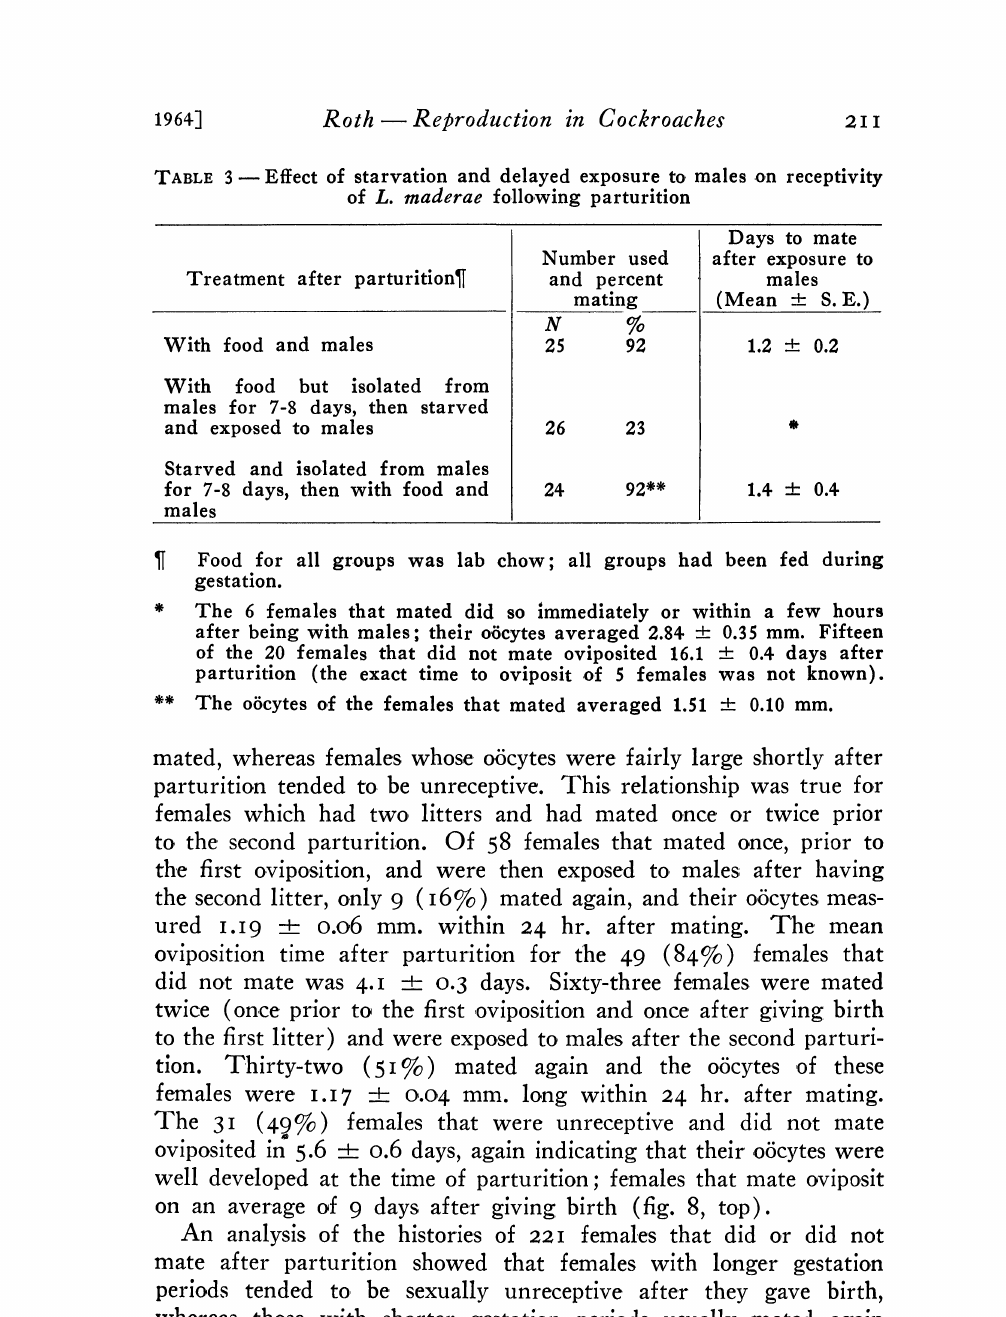
TABLE 3- Effect of starvation and delayed exposure to, males .on receptivity of L. maderae folio,wing parturition Treatment after parturition With food and males With food but isolated from males for 7-8 days, then starved and exposed to males males